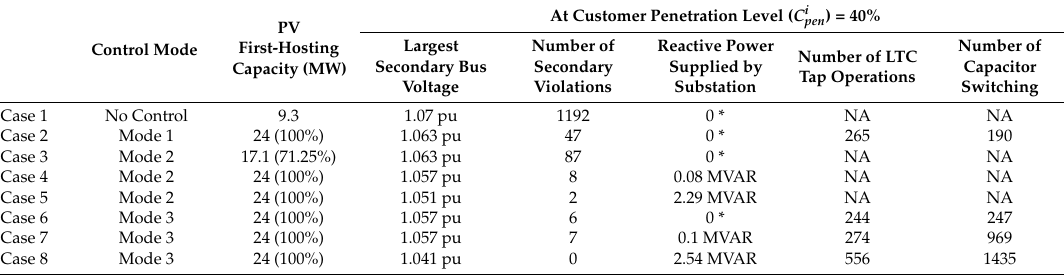
Table 3. Comparison of the voltage control